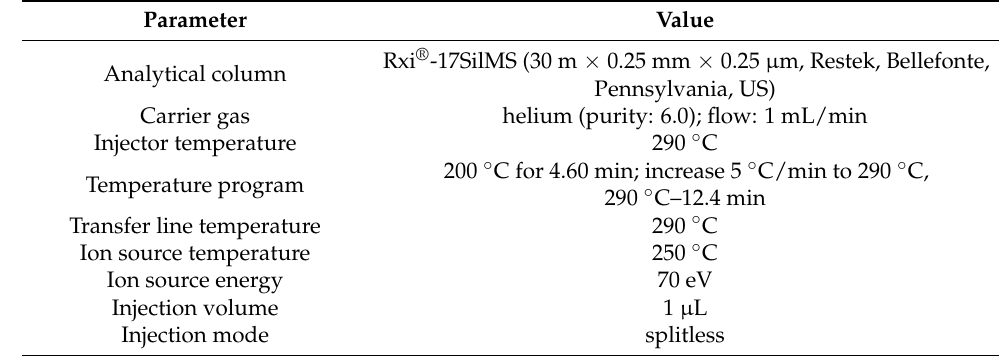
Table 8. Instrumental conditions of